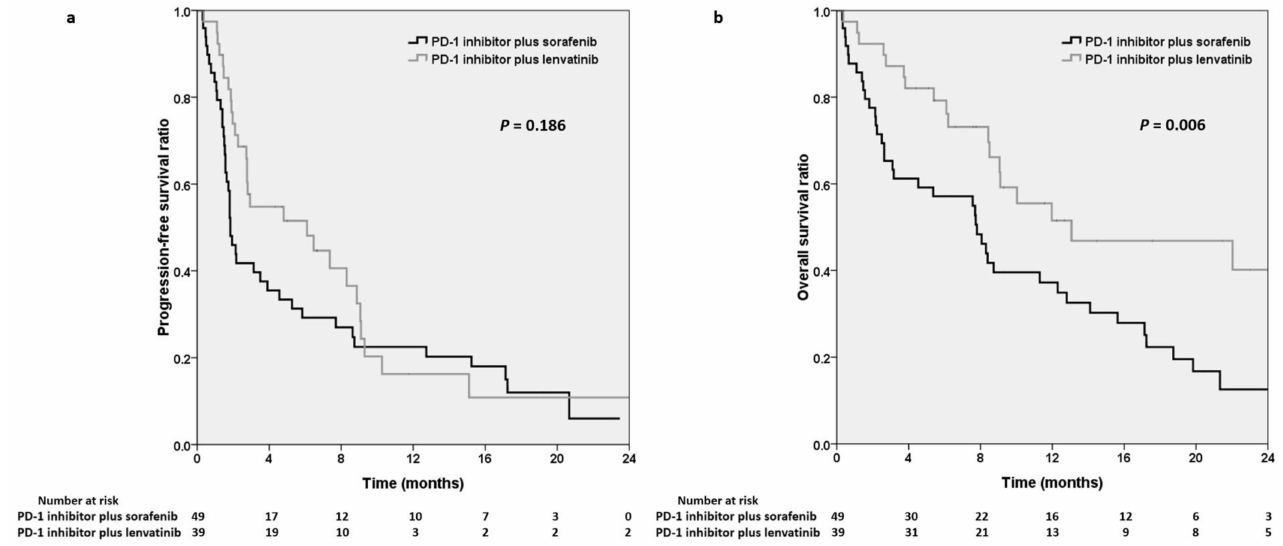
Figure 2. Kaplan–Meier analysis demonstrating progression-free survival ( a ) and overall survival ( b ) for the PD-1 inhibitors plus sorafenib and the PD-1 inhibitors plus lenvatinib. PD-1, programmed cell death protein-1.